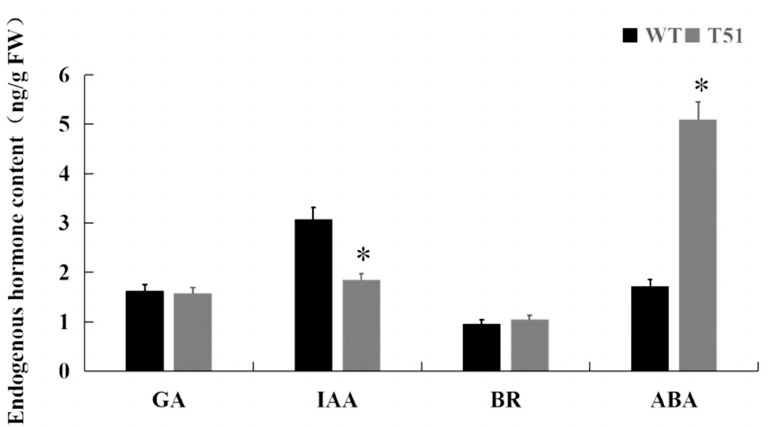
Figure 3. Endogenous hormone content of T51 and WT. Note: ‘*’ indicates the significant difference in Duncan’s multiple comparisons when p < 0.05.